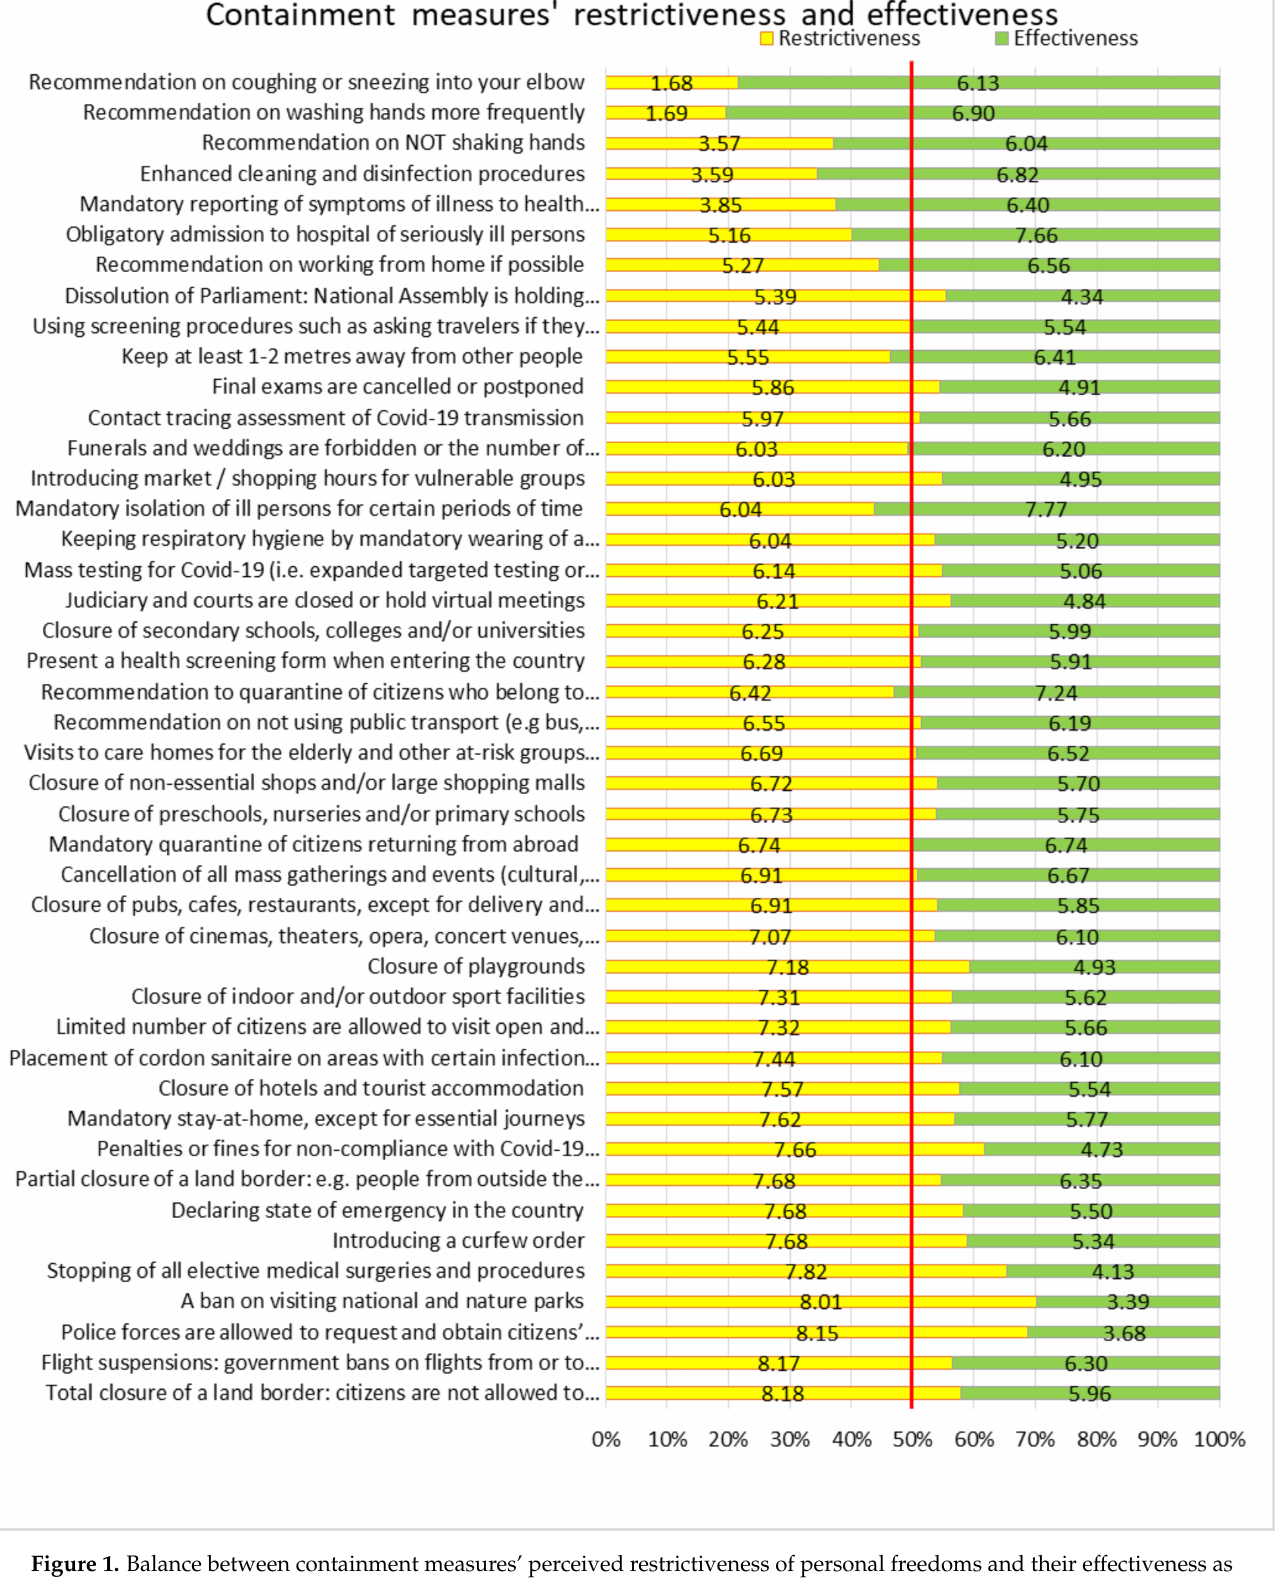
Figure 1. Balance between containment measures’ perceived restrictiveness of personal freedoms and their effectiveness as assessed by study